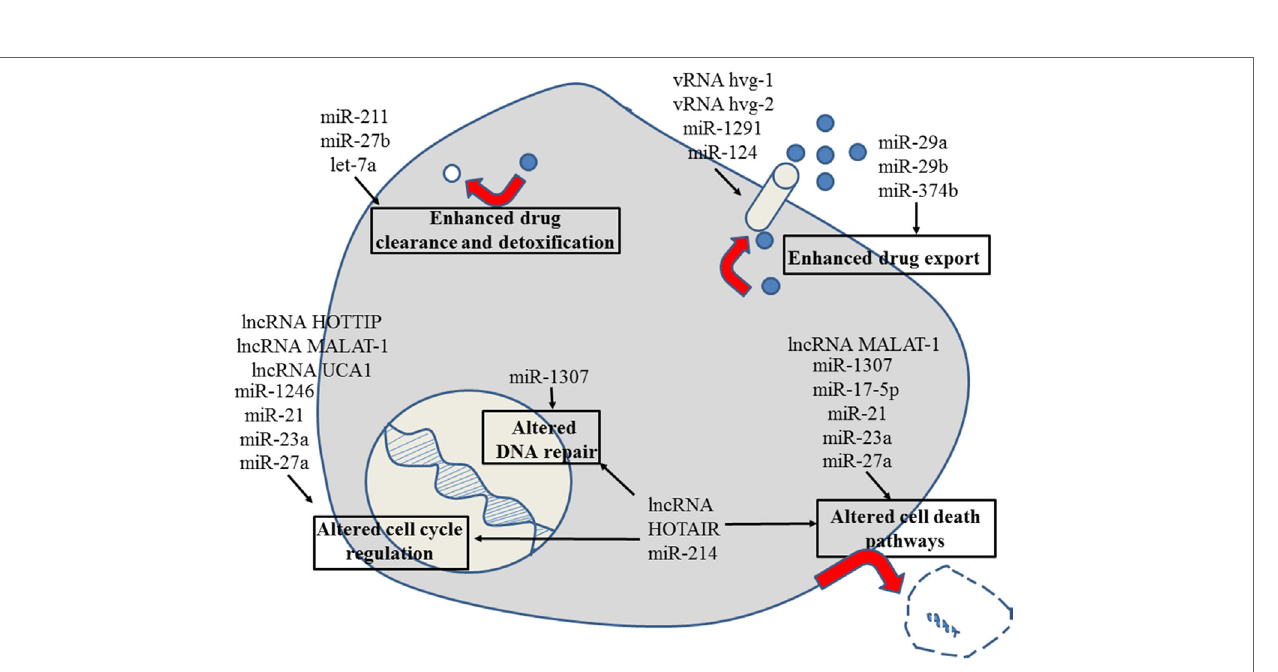
FiGURe 5 | Role of non-coding RNAs for the different reasons that can cause resistance to anticancer drugs in pancreatic cancer. For details about target genes and regulated protein expression by the non-coding RNAs, see text.